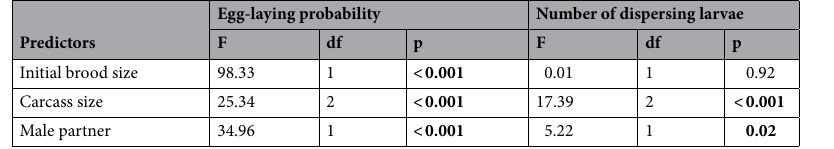
Table 1. Summary of models for the effects of initial brood size, carcass size, and the male partner on the probability of producing a second clutch and the number of dispersing larvae. Significant values are in bold.